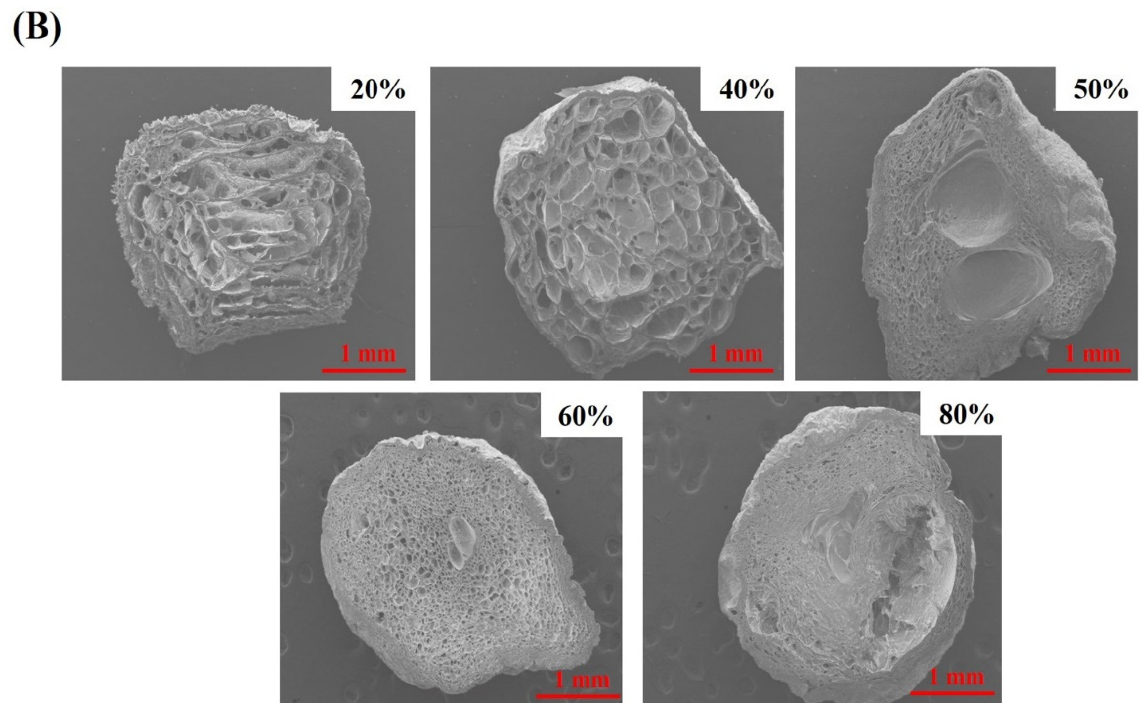
Figure 2. ( A ) Textural properties of gel beads: The hardness (a), springiness (b), cohesion (c), resilence (d), gumminess and chewiness (e) of quercetin-loaded beads with different content of pectin; Effect of pectin content on the water content in hydrogel beads (f). ( B ) SEM image (30 × ) of cross section of gel beads with different pectin content.